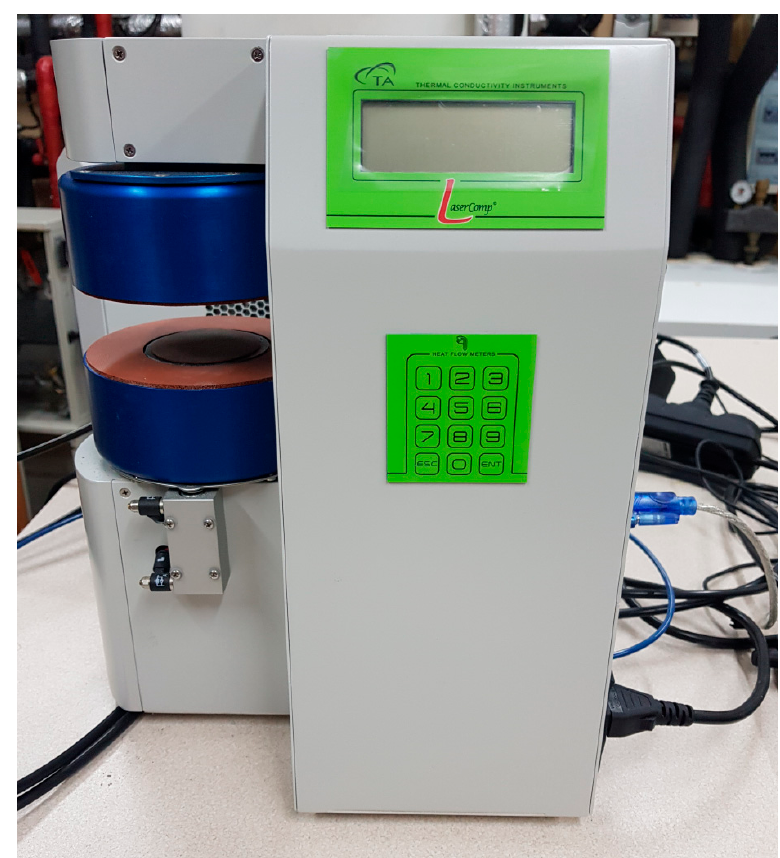
Figure 14. FOX 50: thermal conductivity measurement apparatus .